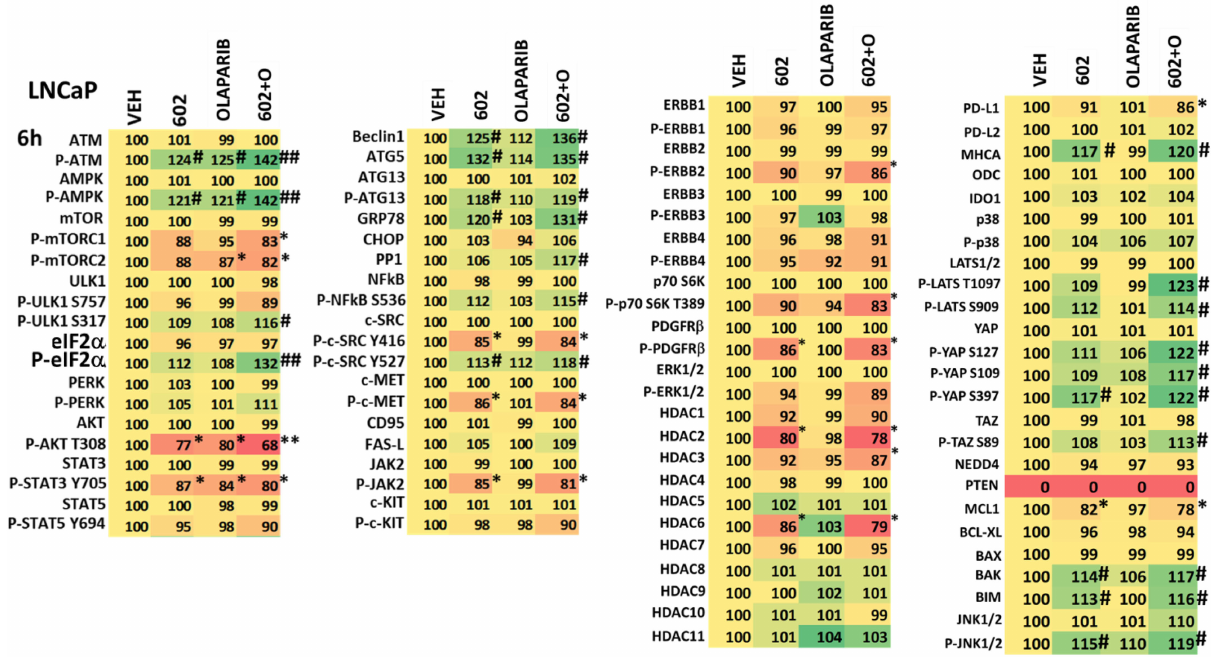
TABLE 2 Regulation of cell signaling by GZ17-6.02 and olaparib in LNCaP prostate cancer cells.